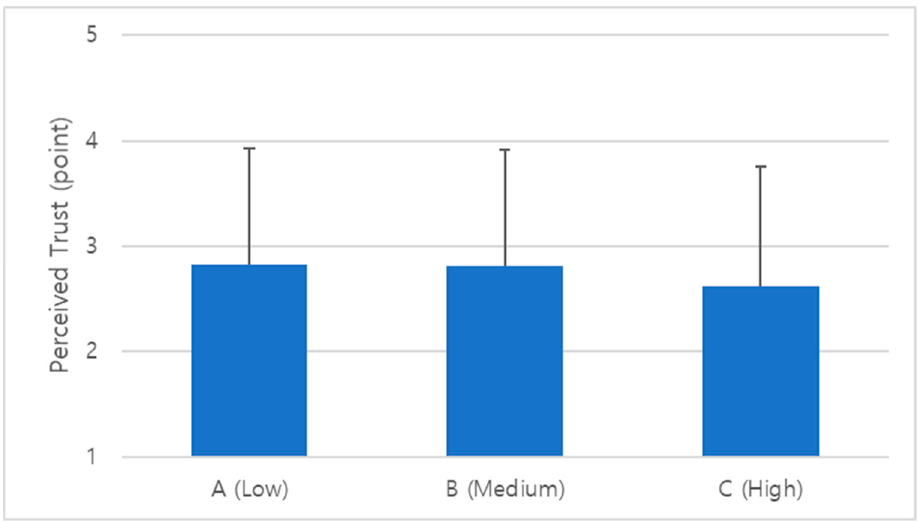
Figure 3. Perceived trust of LDA+SA according to affective level.